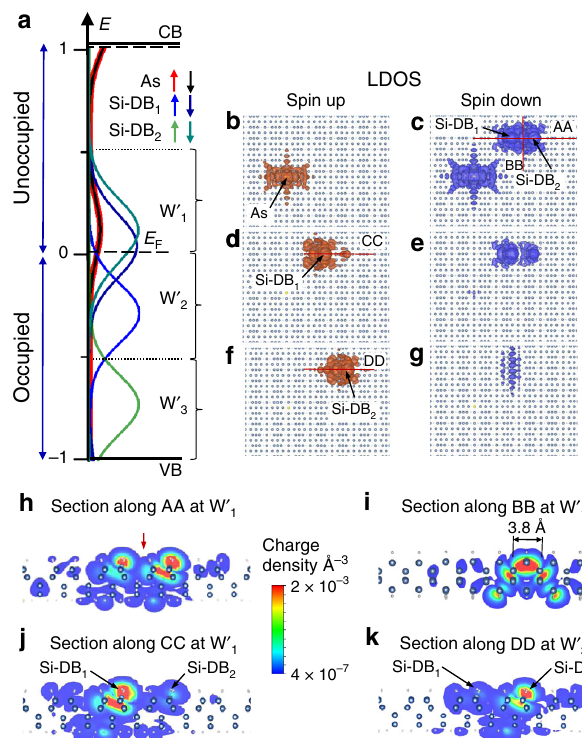
Fig. 4 Calculated spatial distributions of charge for a Si-DB ⊥ . a Calculated PDOS curves at the two Si-DB ⊥ and the As atom (recall from Fig. 2) for three selected energy windows W ′ 1 – W ′ 3 . b – g Spin-up (brown) and spin-down (blue) local density of state (LDOS) isosurfaces on the silicon slab for the three energy windows W ′ 1 – W ′ 3 . The chosen section of the slab is represented with blue and white balls as Si and H atoms, respectively. h – k Cross-sectional plot of the partial LDOS along the AA, BB, CC, and DD axes de fi ned by the red lines in c , d , and f . The differences of hybridization of the Si-DBs between Figs. 3 and 4 can be clearly observed in Fig. 3d, f compared to Fig. 4d,